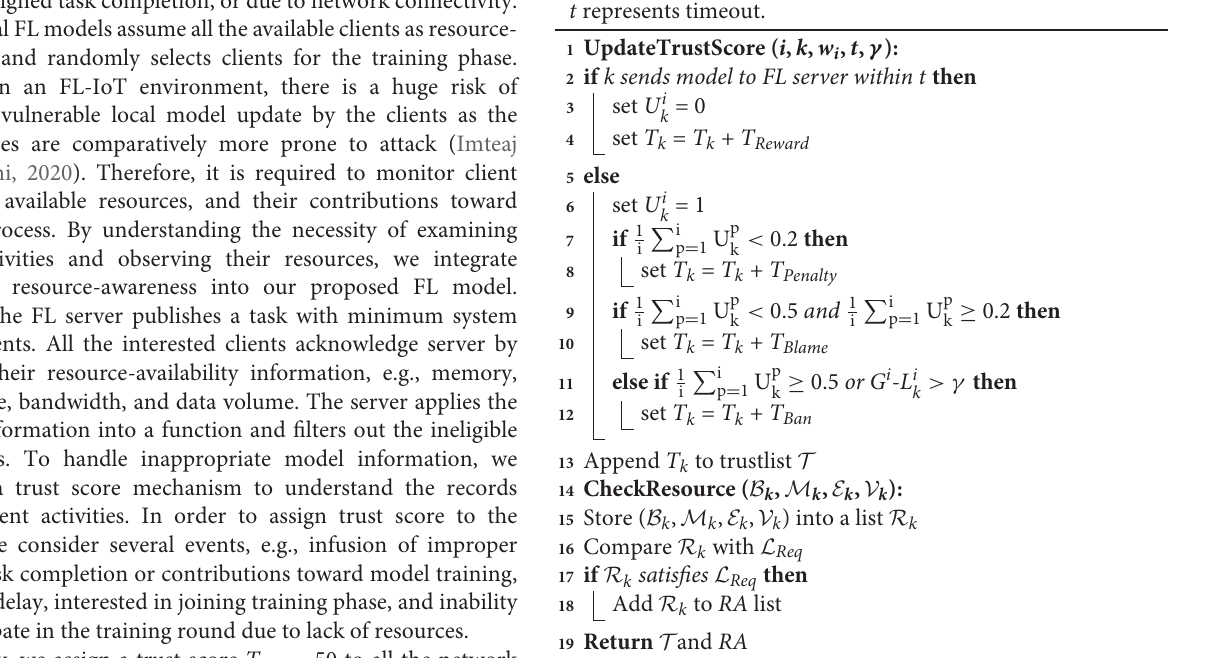
Algorithm 1: Activity and Resource Checking.